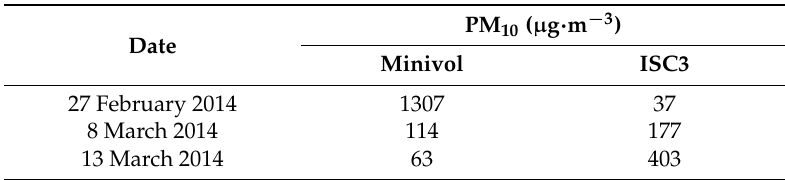
Table 4. Comparison of 24-h PM 10 average concentrations between Minivol and Industrial Source Complex (ISC3) model during CF entrance